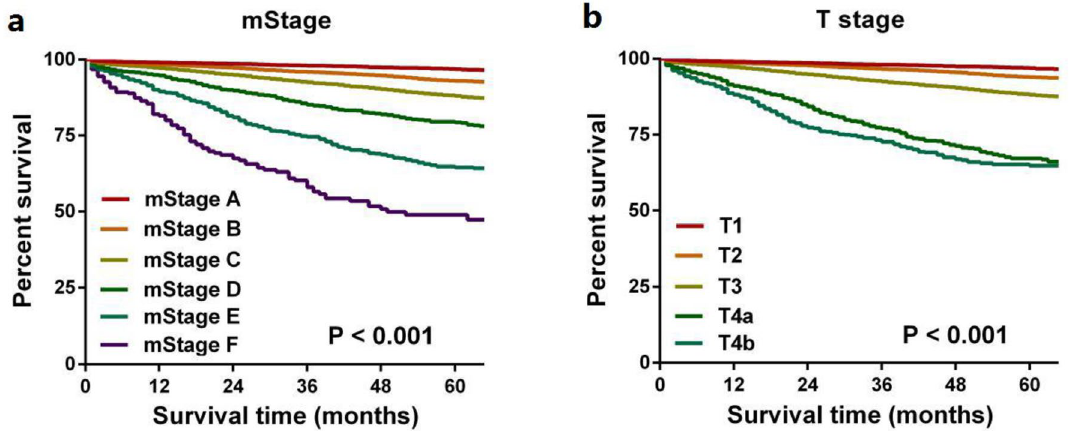
Figure 4. Kaplan–Meier curves stratified by mStage ( a ) and conventional TNM stage ( b ) in the development